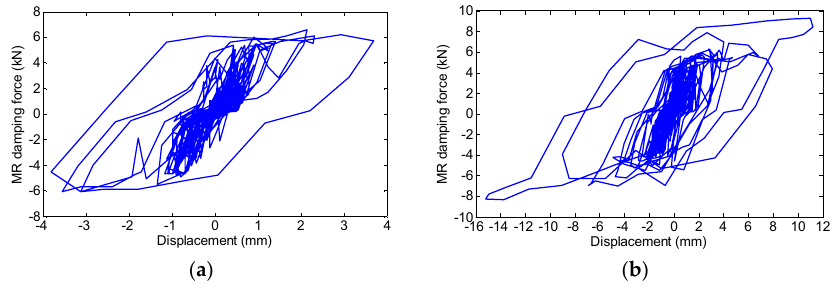
Figure 13. Damper hysteretic curves for El Centro wave with ( a ) fortification intensity, and ( b ) rare intensity of earthquake.